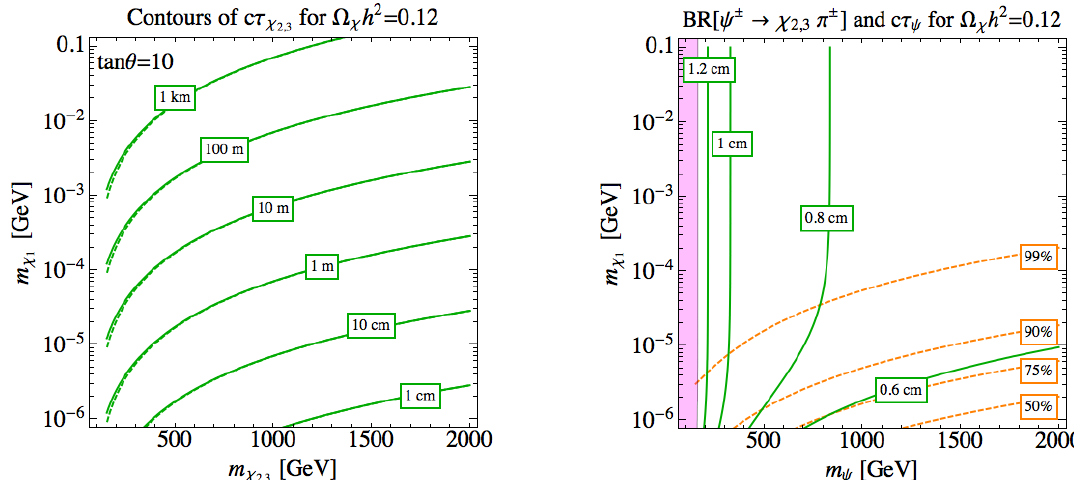
Figure 7 . Left: decay length of the neutral fermions (cid:31) branching ratio (orange dashed lines) and decay length (green solid lines) of (cid:6) ! (cid:31) shaded region is excluded by searches for disappearing tracks [57, 58]. The coupling y is set in both plots by requiring (cid:10) h 2 = 0 :